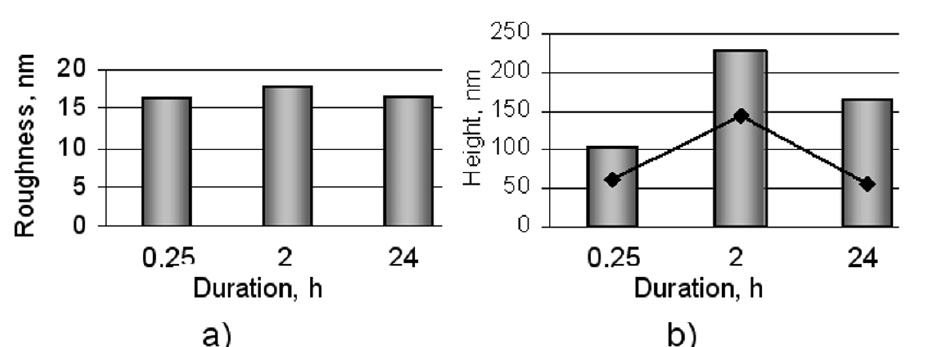
Figure 11. Dependence of layer mean square roughness (a) and height (b) on the duration of PA treatment in 0.025 mol dm -3 K